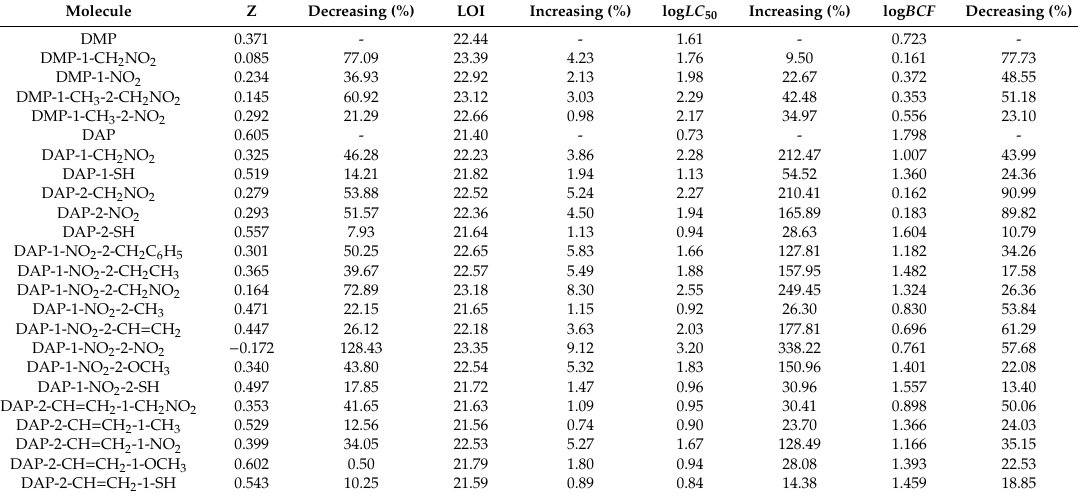
Table 7. Comprehensive evaluation value Z, LOI, log LC 50 , log BCF of PAEs derivatives based on 3D-QSAR models and their degree of change. Molecule Z Decreasing